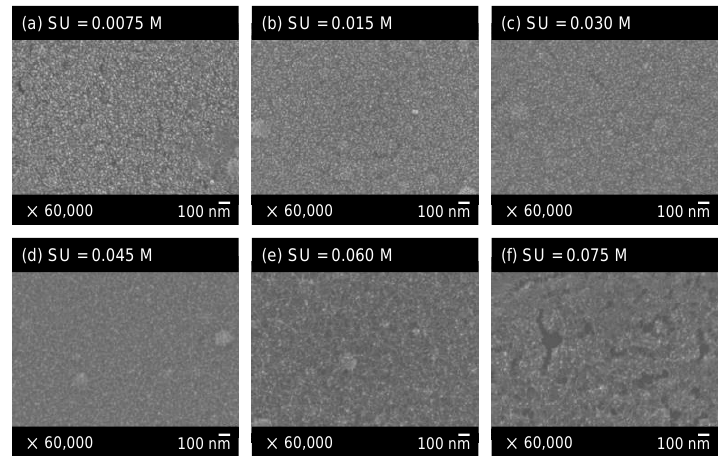
Figure 2. Surface morphologies of Zn(Se,OH) films deposited with a constant ammonia concentration of 1.4 M, and the selenourea concentrations of ( a ) 0.0075 M; ( b ) 0.015 M; ( c ) 0.03 M; ( d ) 0.045 M; ( e ) 0.06 M and ( f ) 0.075 M.